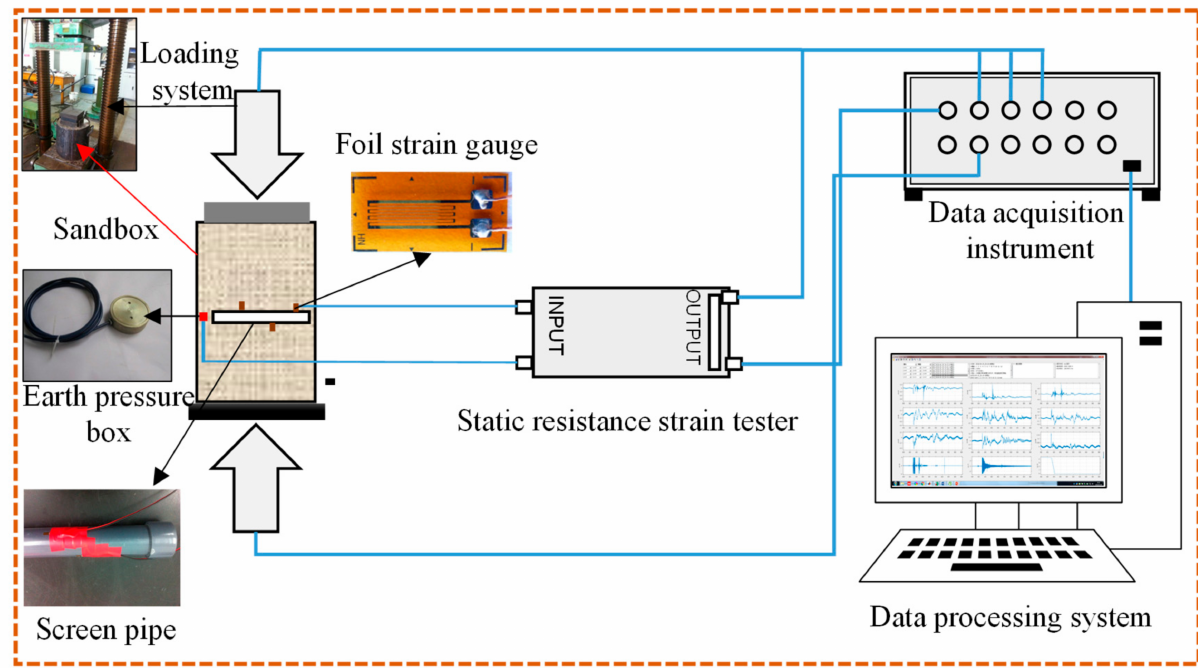
Figure 1. Schematic of the experimental